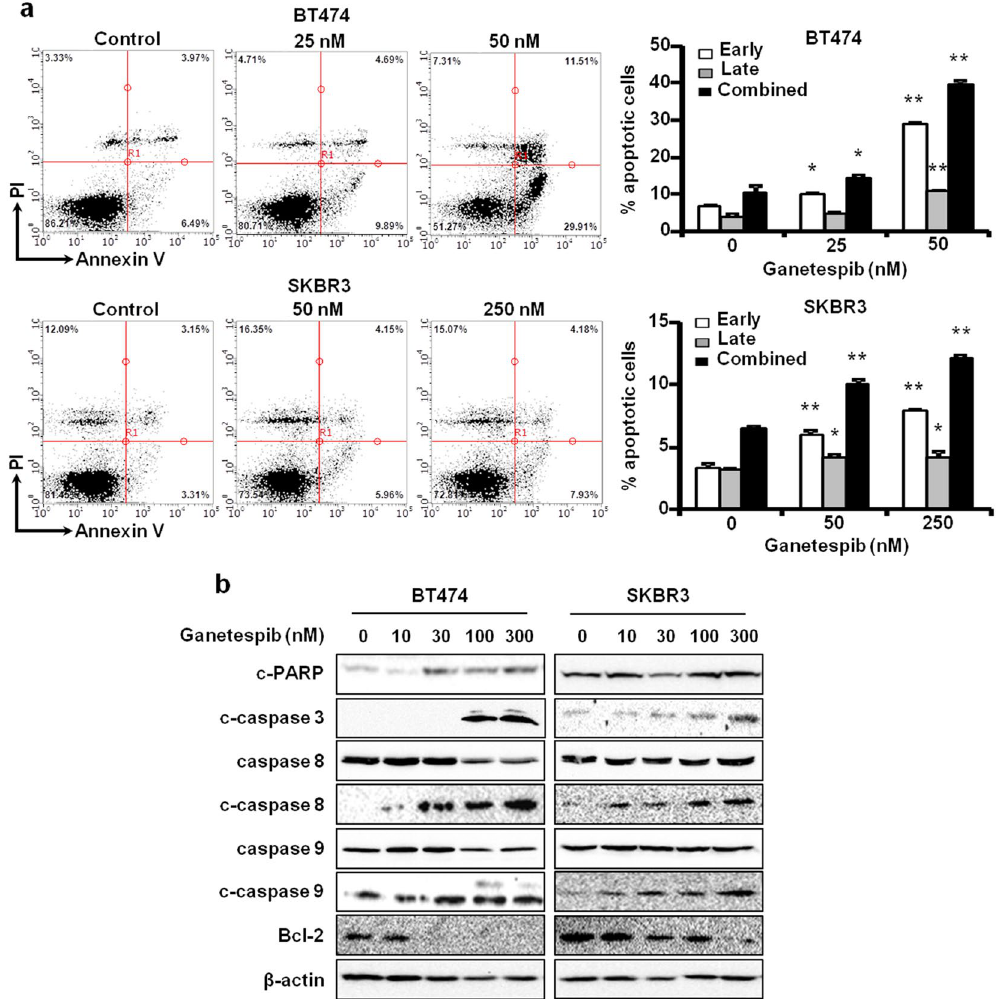
Figure 3. Ganetespib induces apoptosis in ErbB2 + breast cancer cells. ( a ) BT474 and SKBR3 cells were treated with ganetespib (25–250 nM) for 48 hours. Then, cells were Annexin V/PI-stained and analyzed with flow cytometry. The percentages of cells in early (Annexin V + /PI − ) and late (Annexin V + /PI + ) stages of apoptosis are graphed in the panels to the right of the representative dot plots. ( b ) Cropped images of Western blots at the target molecular weights for the indicated apoptotic markers are shown in ganetespib-treated (0, 10, 30, 100, 300 nM for 16 hours) BT474 and SKBR3 cells. All values are graphed as the means ± S.E. ( * P ≤ 0.05; ** P ≤ 0.01 as compared to the corresponding untreated